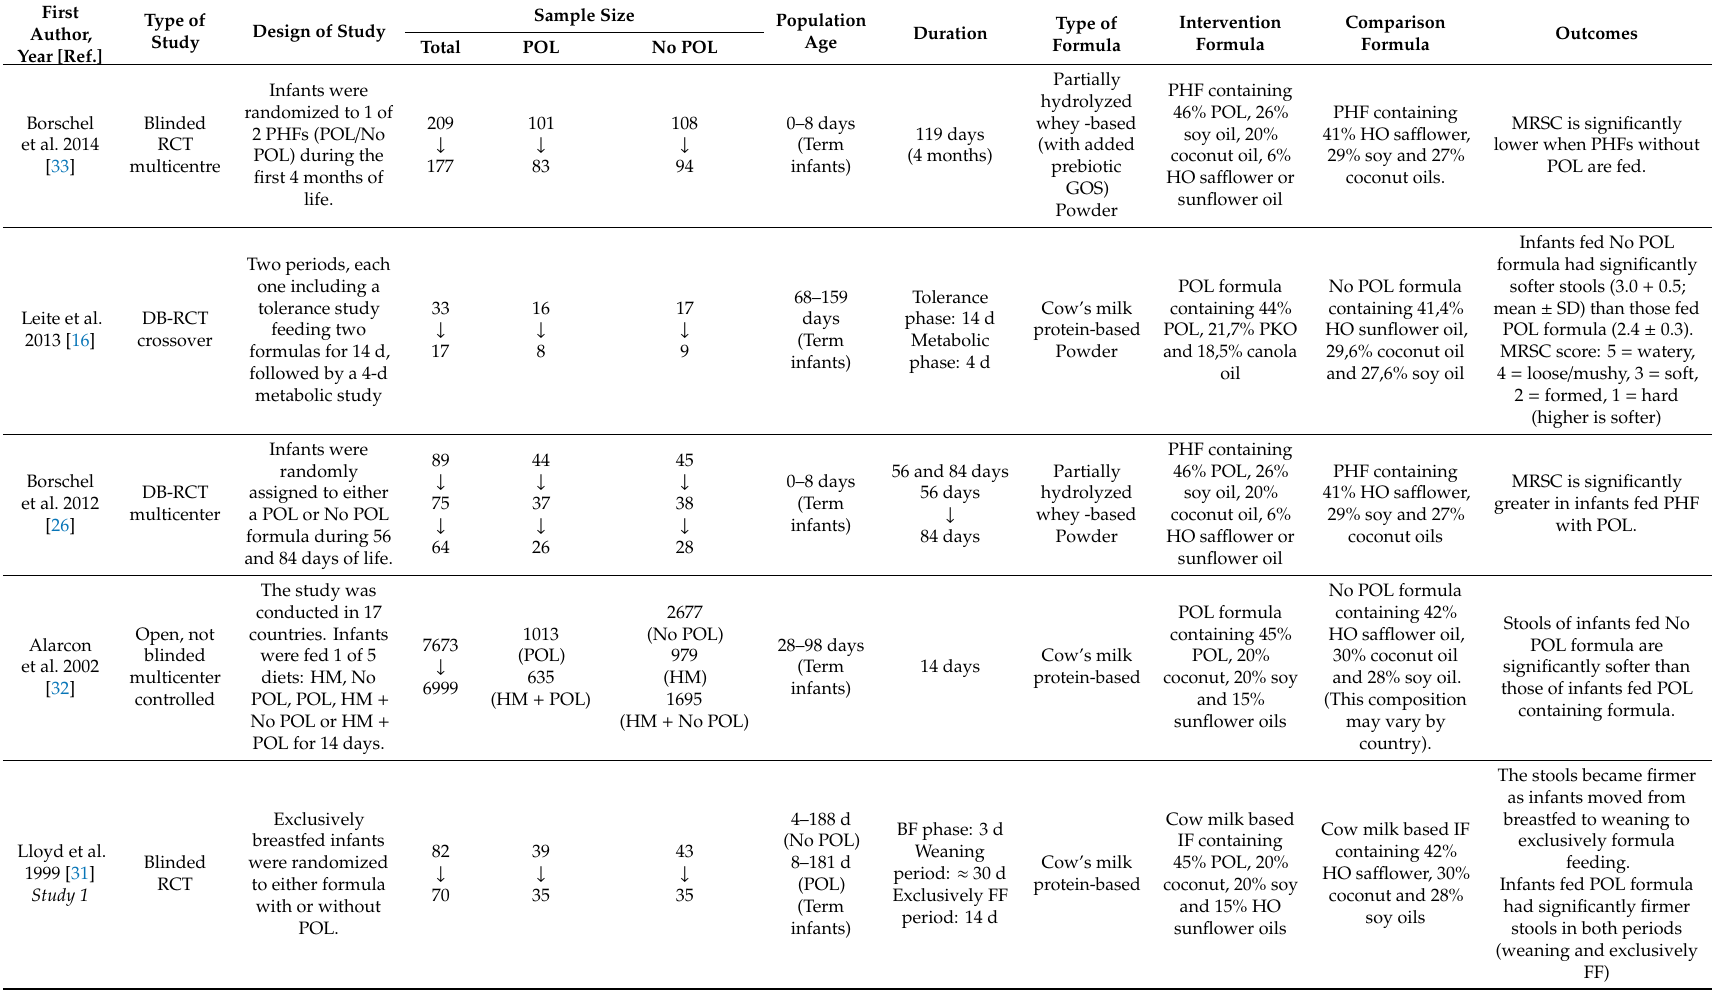
Table 4. Characteristics of studies describing stool consistency e ff